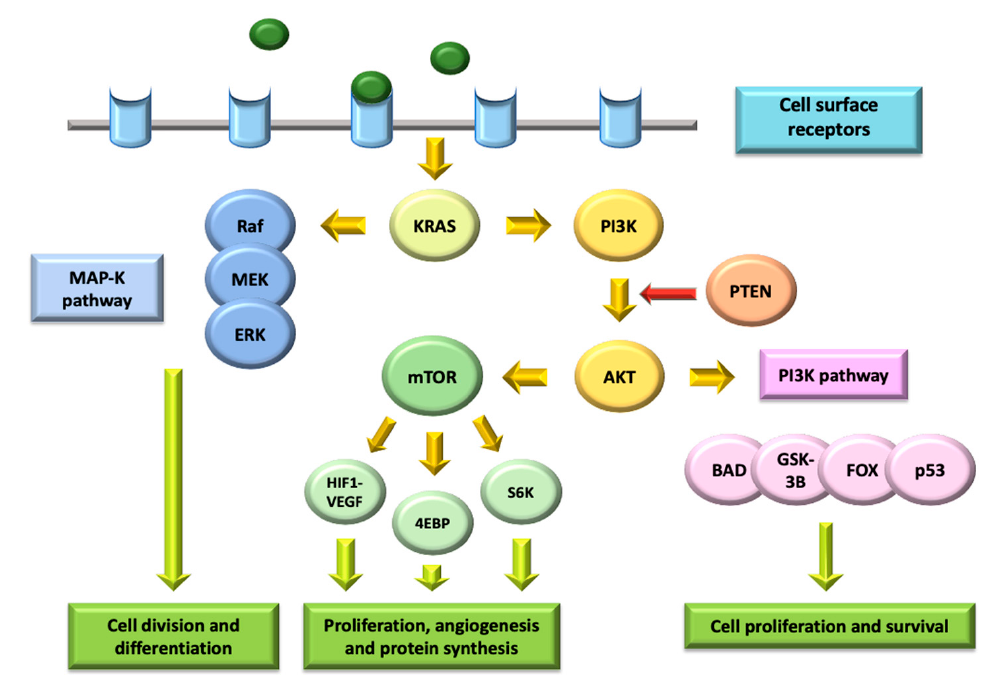
Figure 3. Phosphatidylinositol-3-kinase (PI3K)/Akt/ mammalian target of rapamycin (mTOR) pathways and their interaction with mitogen-activated protein-kinase signaling.